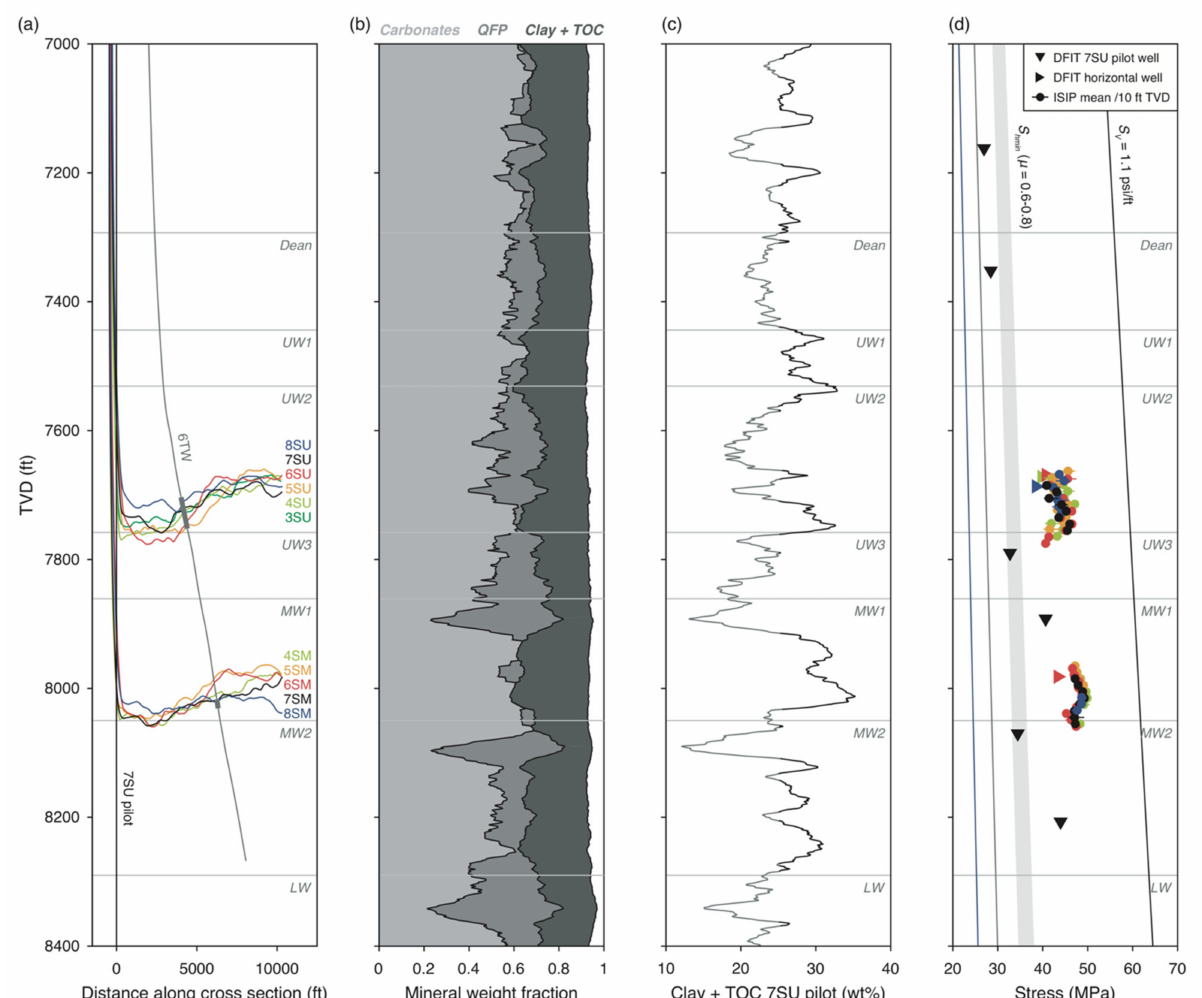
Figure A4. ( a ) Well trajectories in cross section shifted according to stratigraphic depth with respect to the pilot well (Figures A2 and A3). ( b ) Ternary composition as a function of depth in the pilot well derived from Fourier transform infrared spectroscopy. ( c ) Clay + total organic carbon (TOC) as a function of depth. Regions exceeding 25 wt% are highlighted in black. ( d ) Stress, mudweight, and pore pressure as a function of depth. Measurements of S hmin are from DFITs in the pilot well and the toes of several horizontal wells (Figure A1). Stress measurements in both the Upper and Middle Wolfcamp are shifted according to stratigraphic depth with respect to the pilot